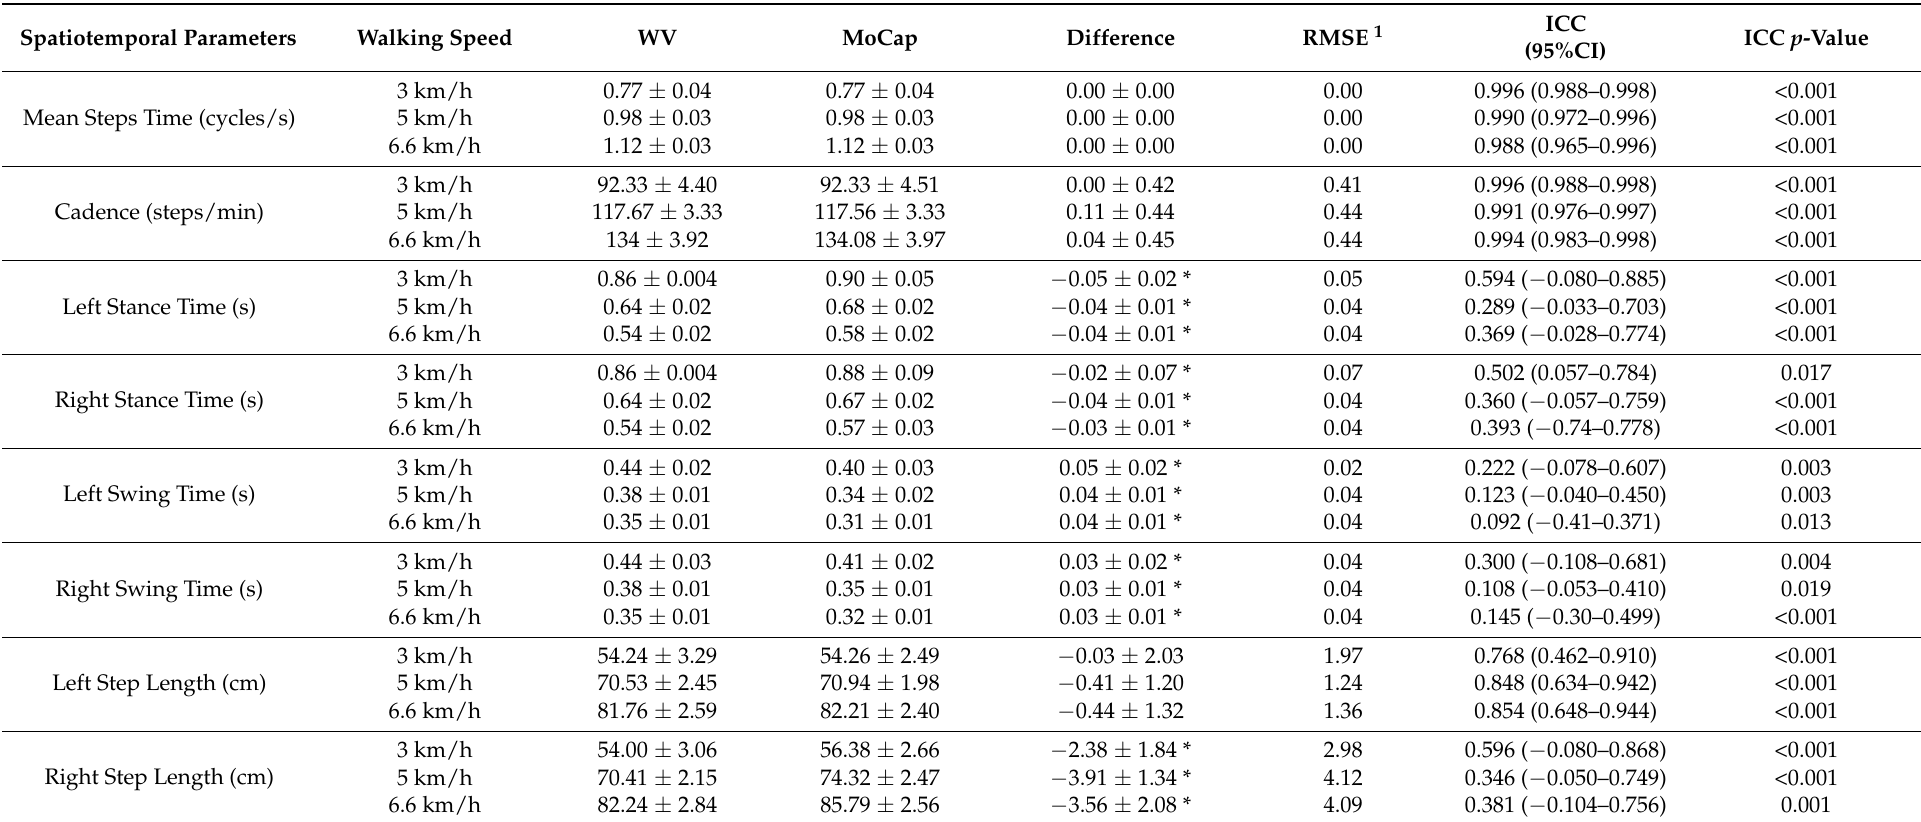
Table 2. Spatiotemporal parameters. Spatiotemporal parameters obtained from the WV and MoCap systems, at all the tested walking speeds. All the values are reported as mean ± standard deviation, considering the values recorded from all the volunteers. Per each walking speed, the difference between the WV and MoCap (Difference), the Root Mean Square Error (RMSE), the ICC, with 95% CI and relative p value, are also